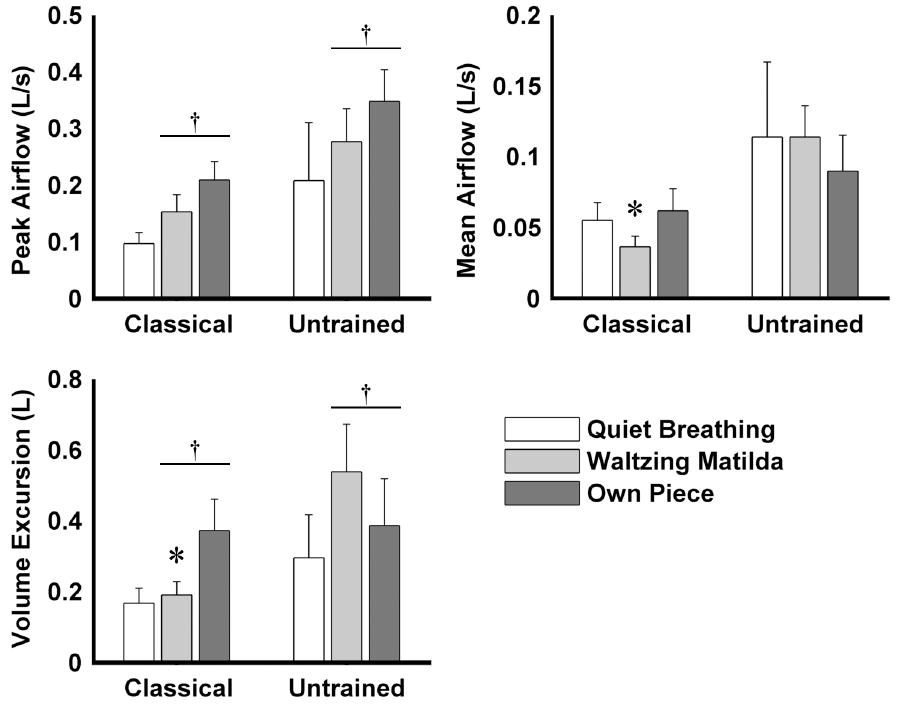
Fig 6. Peak airflow, mean airflow, and volume excursion of classical singers and untrained individuals during each of the three tasks assessed. Volume excursion was assessed as the difference between the volume at initiation and termination of expiratory phase of each breath cycle. Mean + SEM are shown. * P < 0.05 vs. untrained individuals. † P < 0.05 vs. quiet